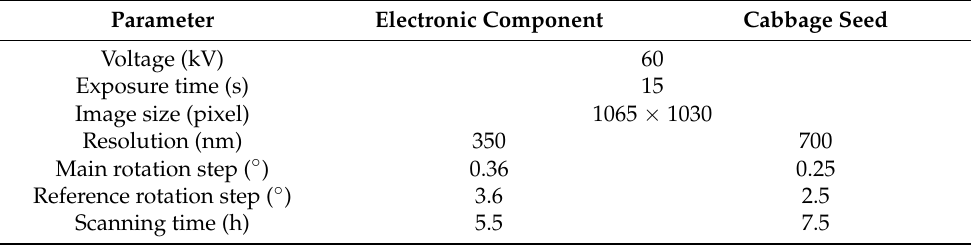
Table 4. Scan parameters of 3D reconstruction